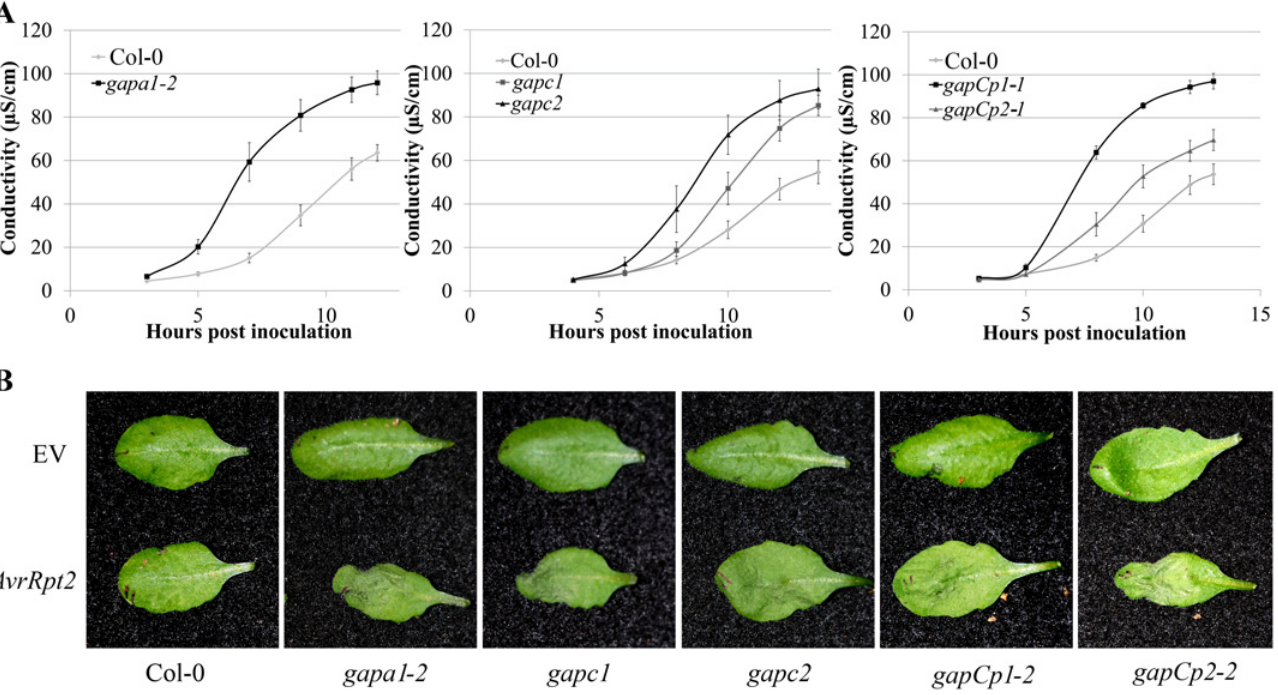
Fig 2. GAPDH knockouts displayed an accelerated hypersensitive response (HR) during effector-triggered immunity. (A) Electrolyte leakage measurements of individual GAPA1-2 , GAPC1 , GAPC2 , GAPCp1-1 and GAPCp2-1 KO lines. Four-week-old leaves were infiltrated with Pst DC3000 AvrRpt2 at a concentration of 4×10 7 CFU mL-1. Values represent means ± SE (n = 4). (B) Macroscopic HR phenotype of Col-0 and GAPDH knockouts 10h post syringe infiltration with Pst DC3000 AvrRpt2 . DC3000 empty vector (EV) control is shown as the top leaf. Bacterial concentrations were the same as (A).